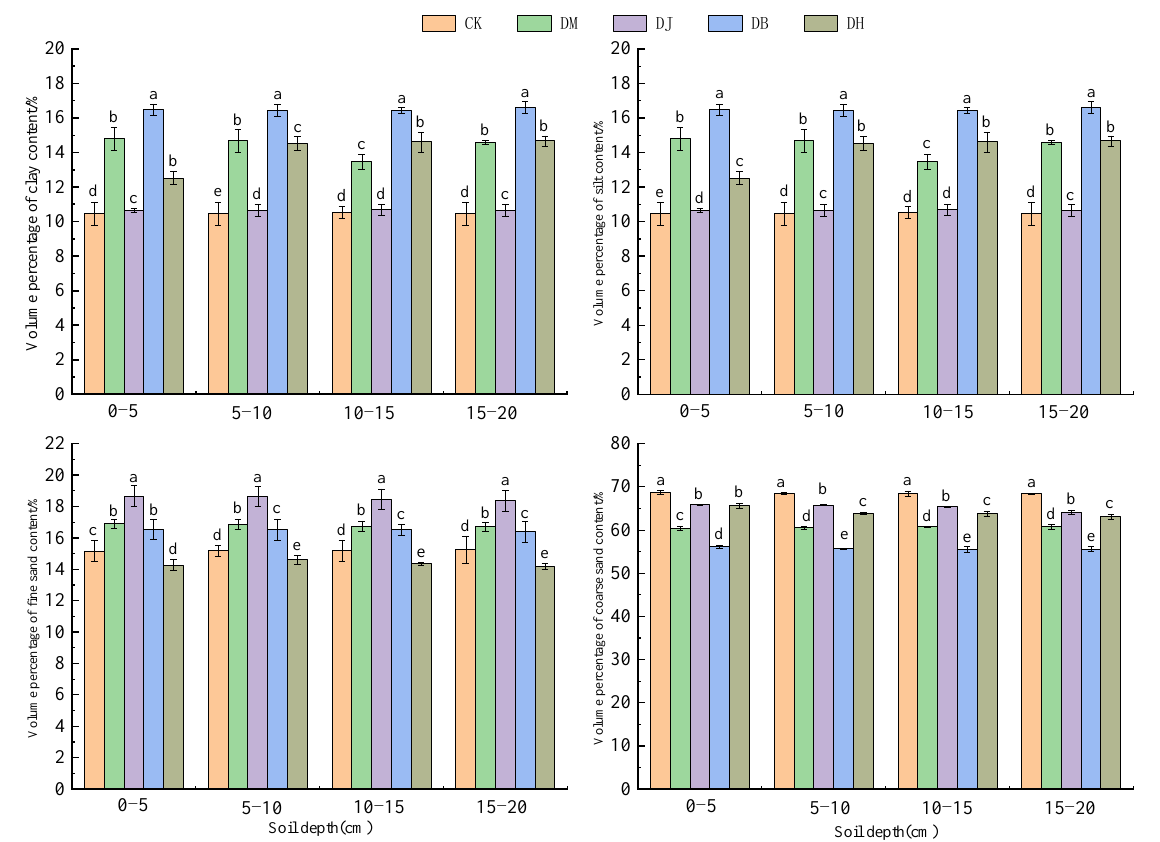
Figure 6. Changes in the distribution of soil particles in different treatments.